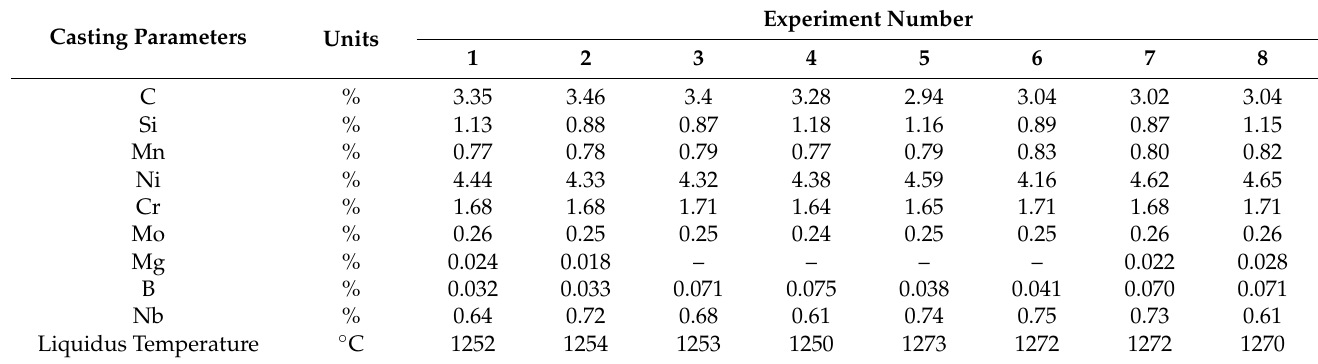
Table 5. Casting parameters of each experiment.